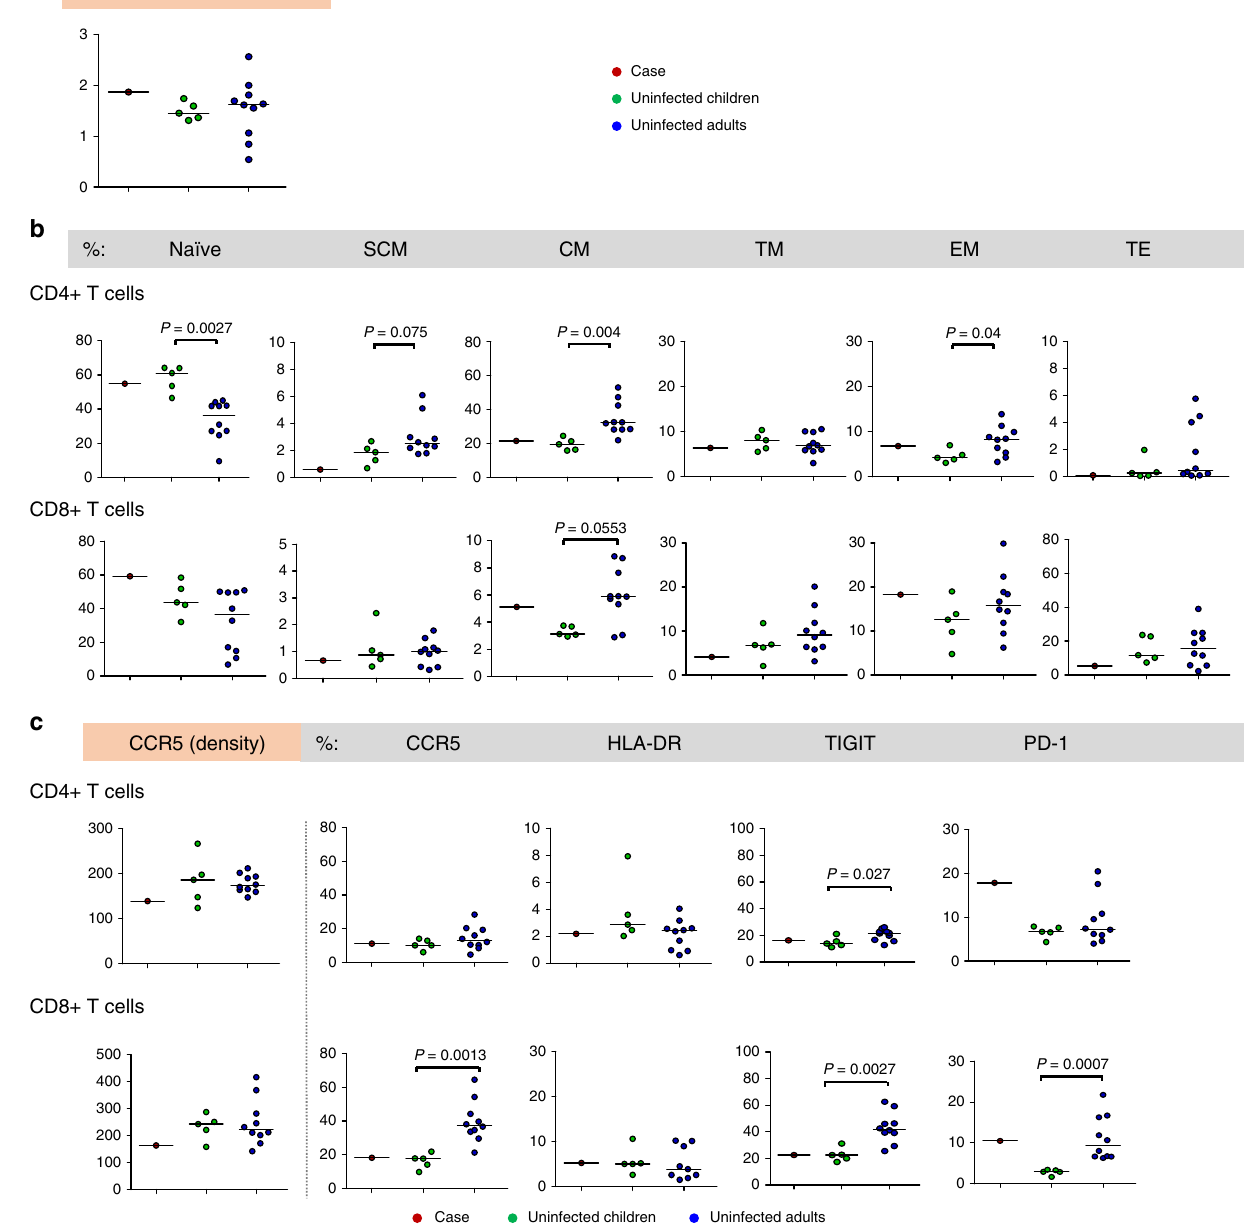
Fig. 5 Immunophenotyping of CD4 + and CD8 + T cells. a – c Cell parameters determined by fl ow cytometry for the child at 9.5 years are compared with those of uninfected age-matched children ( n = 5) and uninfected adults ( n = 10): a CD4:CD8 ratio. b Percentages of CD4 + and CD8 + T cell subsets according to stage of differentiation. Naive (CD45RO − CCR7 + CD62L + CD95 − ); SCM: stem cell memory (CD45RO − CCR7 + CD62L + CD95 + ); CM: central memory (CD45RO + CCR7 + CD62L + CD95 + ); TM: transitional memory (CD45RO + CCR7 − CD62L + CD95 + ), EM: effector memory (CD45RO + CCR7 − CD62L − CD95 + ); TE: terminal effector (CD45RO − CCR7 − CD62L − CD95 + ). c CCR5 density and percentages of cells expressing CCR5, HLA-DR (immune activation), TIGIT and PD-1 (immune checkpoint inhibitory molecules) on CD4 + and CD8 + T cells. Uninfected children were compared to adults using two-tailed non-parametric Mann – Whitney U tests; individual data points are shown as coloured circles; medians are shown as solid lines; statistical signi fi cance at P < 0.05 is indicated. One adult outlier (extreme) data point was omitted from the CD8 + HLA-DR + graph; the adult vs. children comparison was not statistically different with or without this data point ( P > RNA extracted from healthy HIV-1-uninfected donors. Positive controls include An in-house ultrasensitive n-qPCR, targeting the highly conserved integrase (IN) gDNA/RNA extracted from known HIV-1-infected individuals. Sequences of primers gene designed using all subtype C sequences available on the Los Alamos HIV and probe are as follows, fi rst-round PCR: n-IN-forward primer-1 5 ′ -TGG CAG TRT Database (https://www.hiv.lanl.gov/), was used to detect subtype C HIV-1 DNA and TCA TTC ACA ATT TTA-3 ′ ; n-IN-reverse primer-1 5 ′ -TCC TGT CYA CYT GCC RNA. Brie fl y, the n-qPCR assay is a two-step PCR with the fi rst PCR being a standard PCR allowed to proceed to end-point (30 cycles) using the Roche Expand HiFi PCR system and the second PCR a hydrolysis probe real-time PCR using Roche LightCycler 480 Probes Master Mix. The total product generated in the fi rst-round PCR is used in the second round. Negative controls include both water and gDNA or